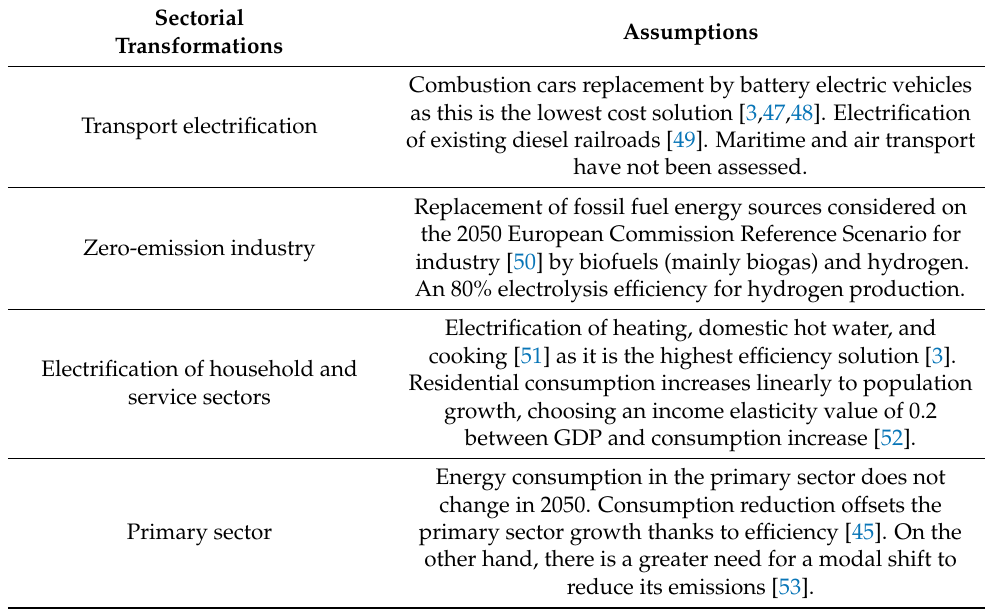
Table 2. Assumptions for 2050